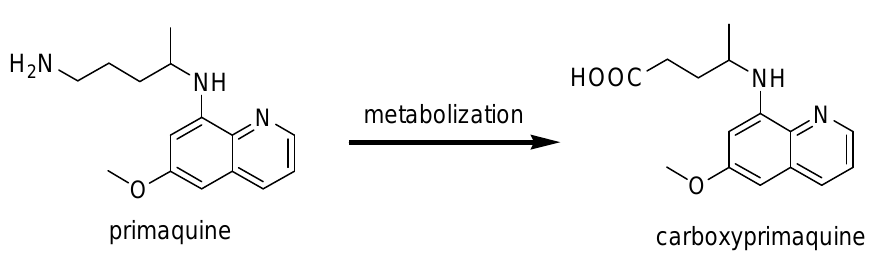
Figure 20 . Metabolism of primaquine.